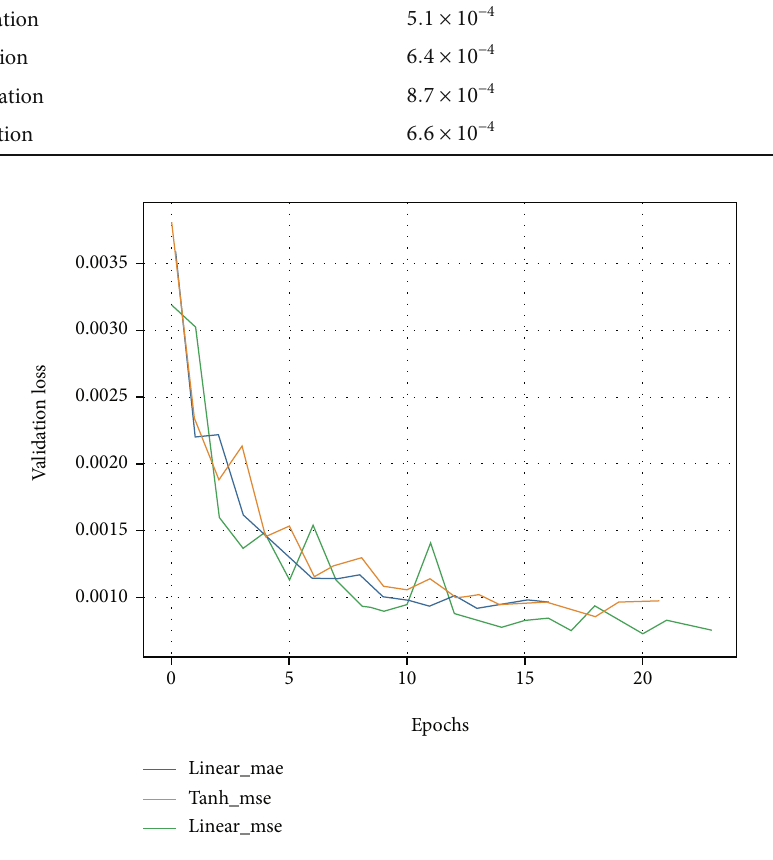
Figure 9: Validation for di ff erent loss and activation functions.